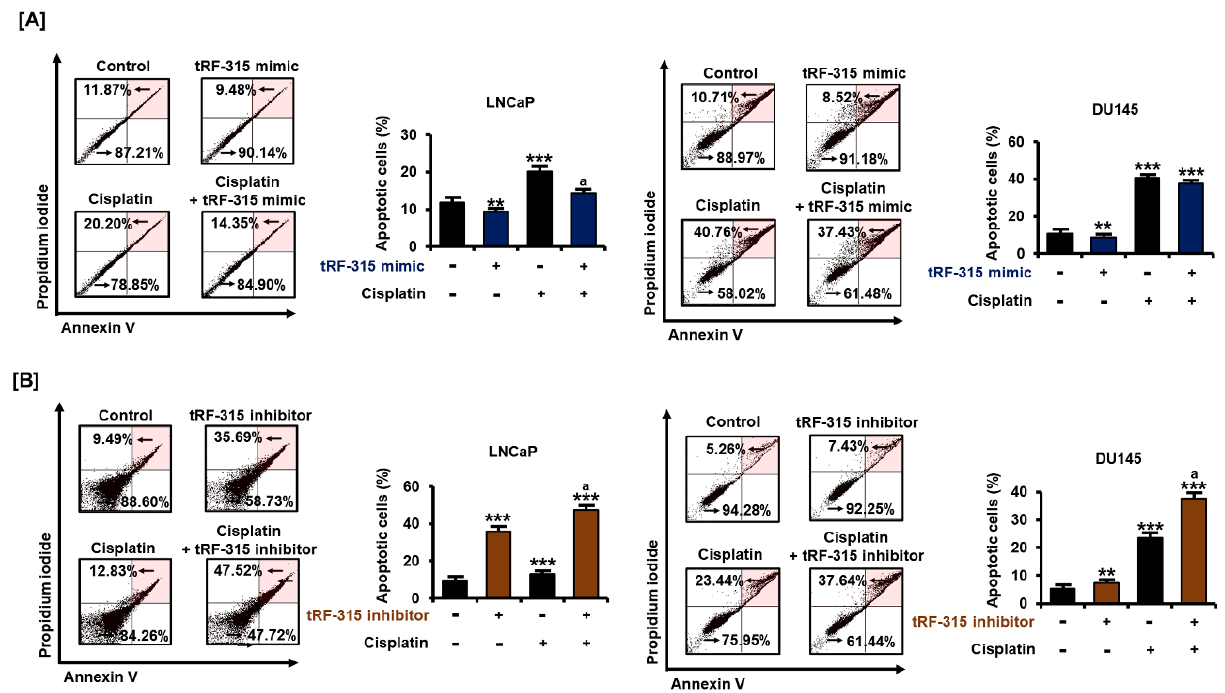
Figure 3. In prostate cancer cells, tRF-315 regulates apoptosis induced by cisplatin. ( A ) Annexin V and propidium iodide- stained cells indicate apoptotic cell death. The percentage of the upper right quadrant was determined to quantify the induction of apoptosis following transfection of cells with tRF-315 mimic (20 nM) for 6 h and cisplatin treatment for 48 h. ( B ) The ratio of the upper right to the lower left quadrants was determined to quantify the induction of apoptosis following the transfection of cells with the tRF-315 inhibitor (20 nM) for 6 h and cisplatin (20 µ M) treatment for 48 h. The value of the control group was expressed as 100%. The data represent three independent experiments. The asterisks indicate significant differences between the treated cells and control cells (*** p < 0.001 and ** p < 0.01). The symbol ‘a’ indicates significant difference compared with cisplatin alone treatment group.